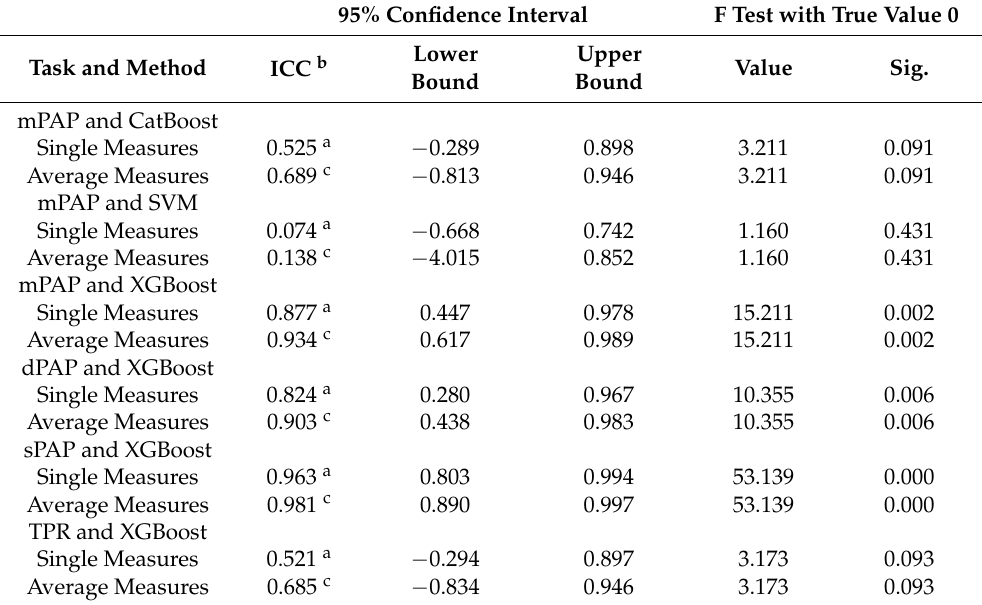
Table 5. ICC of different models and pressure